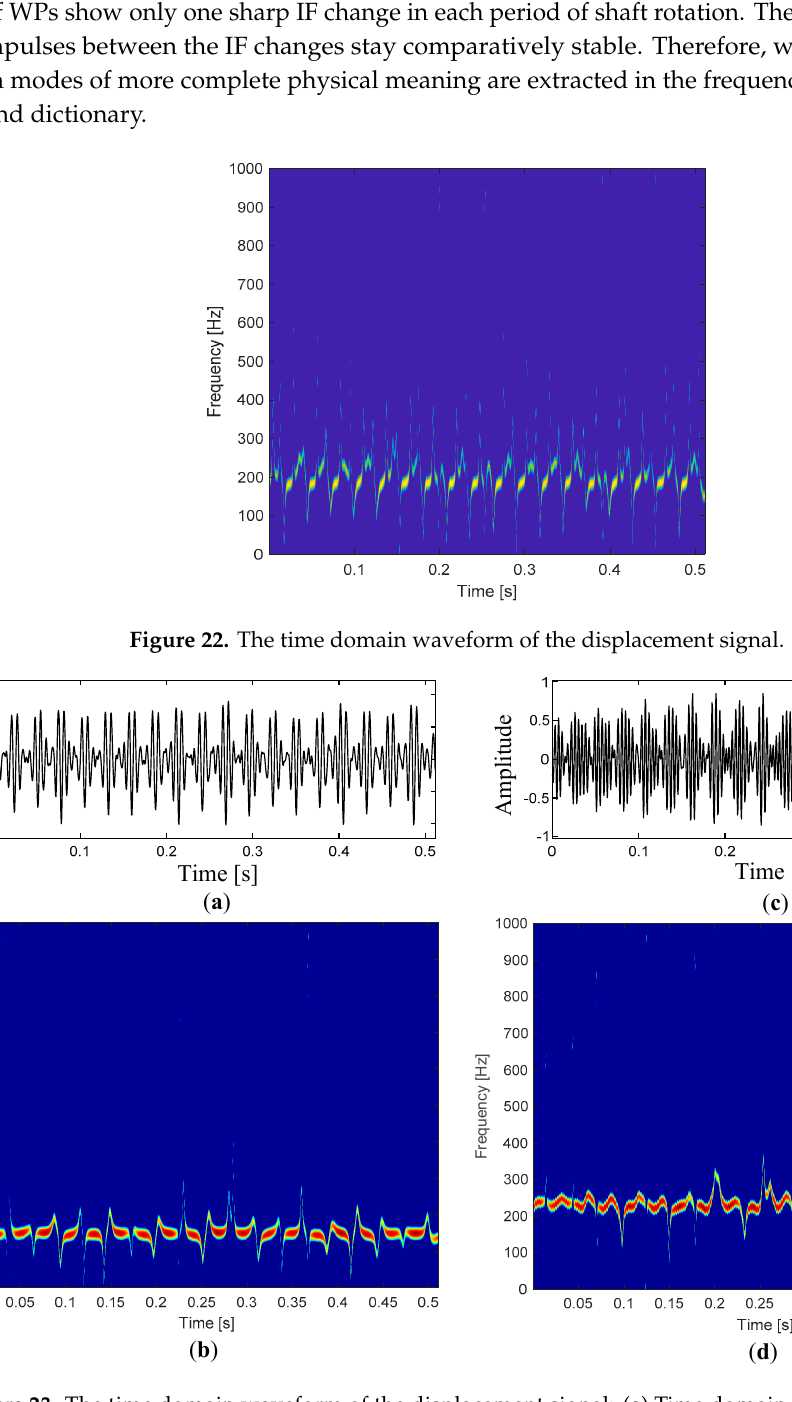
( ) wp n ; ( c ) Time domain waveform 4,3 ( ) wp n . 4,4